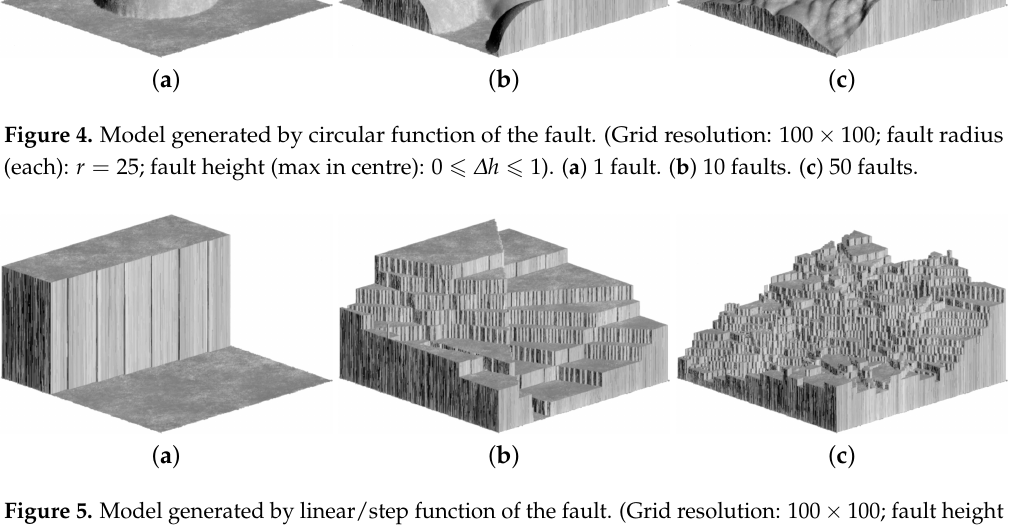
Figure 5. Model generated by linear/step function of the fault. (Grid resolution: 100 × 100; fault height (each): ∆ h = 1). ( a ) 1 fault. ( b ) 10 faults. ( c ) 50